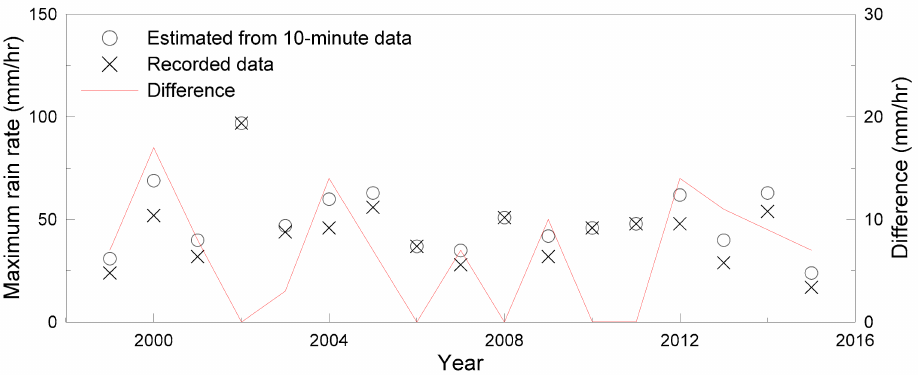
Figure 3. The difference (red line) between annual maximum 60-min precipitation as directly recorded (Xs) and that estimated from 10-min precipitation data (Os).